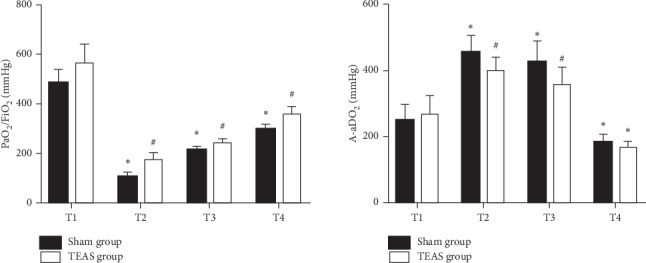
Levels of PaO2/FiO2 and A-aDO2 between 2 groups. ∗P < 0.05 versus group sham transcutaneous electrical acupoint stimulation (TEAS), #P < 0.05 versus T1. T1, before one-lung ventilation; T2, 30 minutes after one-lung ventilation; T3, 2 hours after one-lung ventilation; T4, 1 hour after the operation.